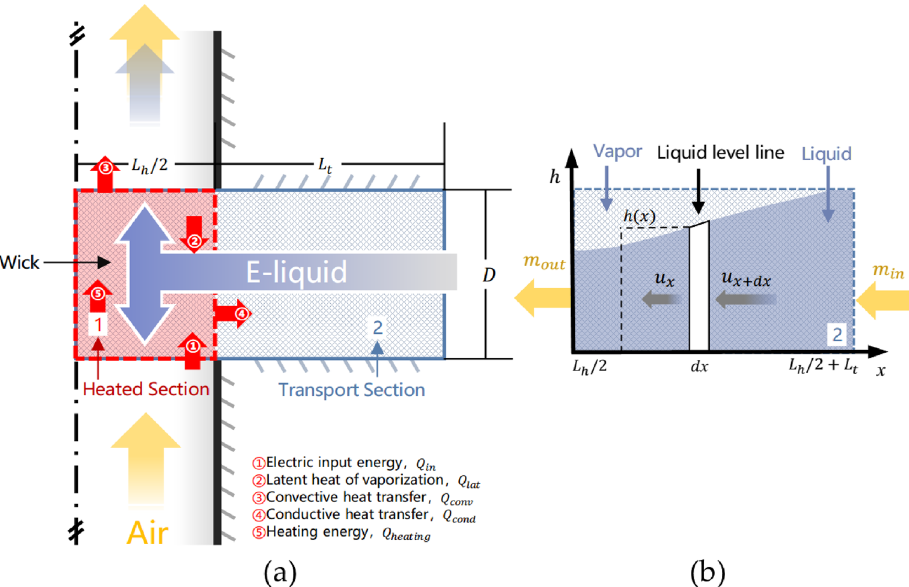
Figure 6. Schematic diagrams of ( a ) a horizontal porous wick with a heated section (zone 1), surrounded by its heating coil, and an e-liquid transport section (zone 2) conducting e-liquid from the liquid reservoir to the wick. Puffing air flows across the heated section and carries the vaporized liquid away as a heated vapor, which subsequently condenses into an aerosol stream; ( b ) a micro-element within the transport section of the wick. The liquid level line illustrates a transient boundary between the remaining liquid and the vapor at time t. h represents the liquid level within the